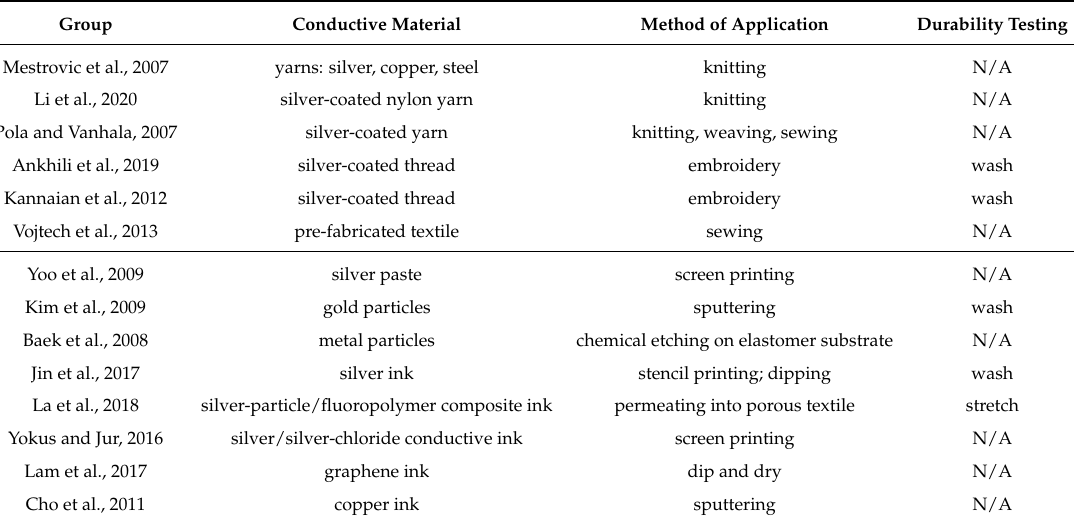
Table 1. This table presents flexible electrode studies found in the literature. Those with an “N/A” value under durability do not list any stretch, bend, or wash testing results. The studies above the divider use conductive threads and yarns, while those below it use conductive pastes, inks, and particles. Note that none of these studies conducted comfort